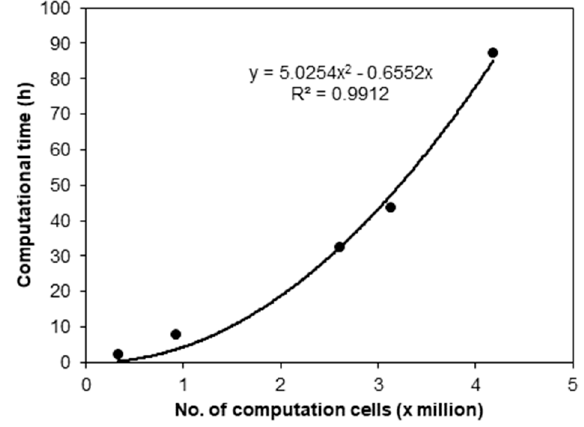
Figure 7. Computation time depending on a number of computational cells (for a single sector).